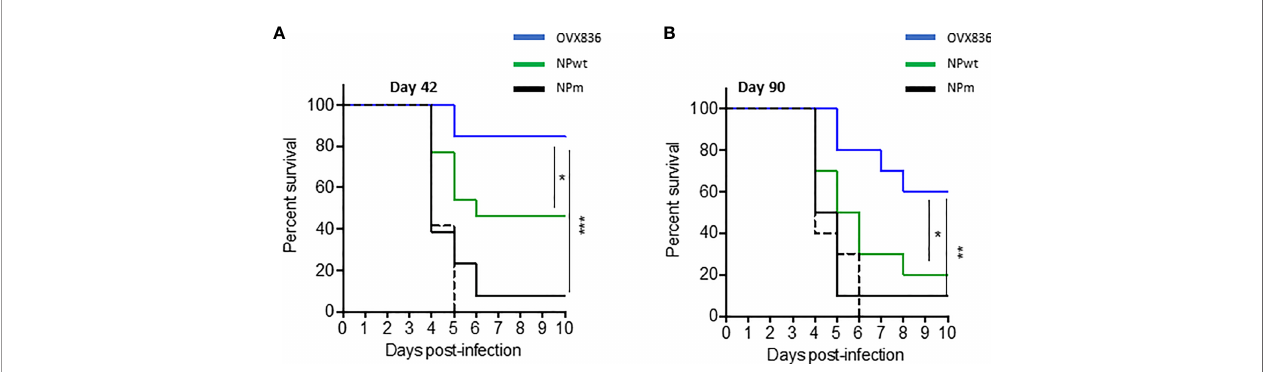
FIGURE 3 | Long-term protection against viral challenges following OVX836 vaccination compared to NPm and NPwt. C57BL/6 mice (n = 12) were immunized twice 3 weeks apart (D0, D21), with 30 µg of NPm, NPwt, OVX836, or buffer (control mice) by the IM route. (A) 42 days and (B) 90 days post- fi rst vaccination, mice were